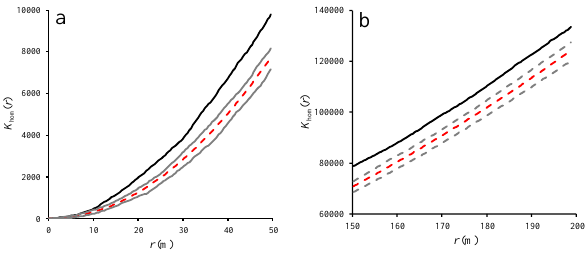
Figure 6. Homogeneous K -function at scales of 0-50 m (a) and 150-200 m (b) for heterogeneous pattern of wild pistachio trees.